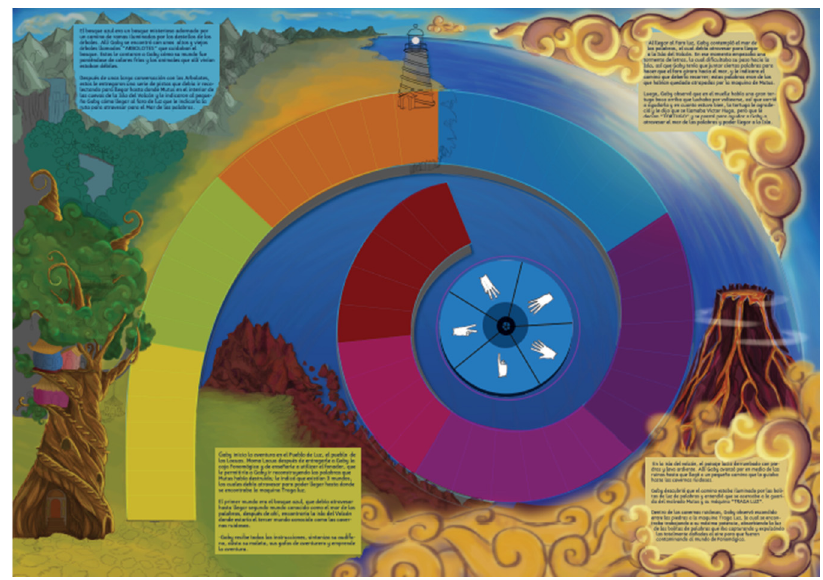
Figure 4. First prototype of the PHONOMAGIC physical board.